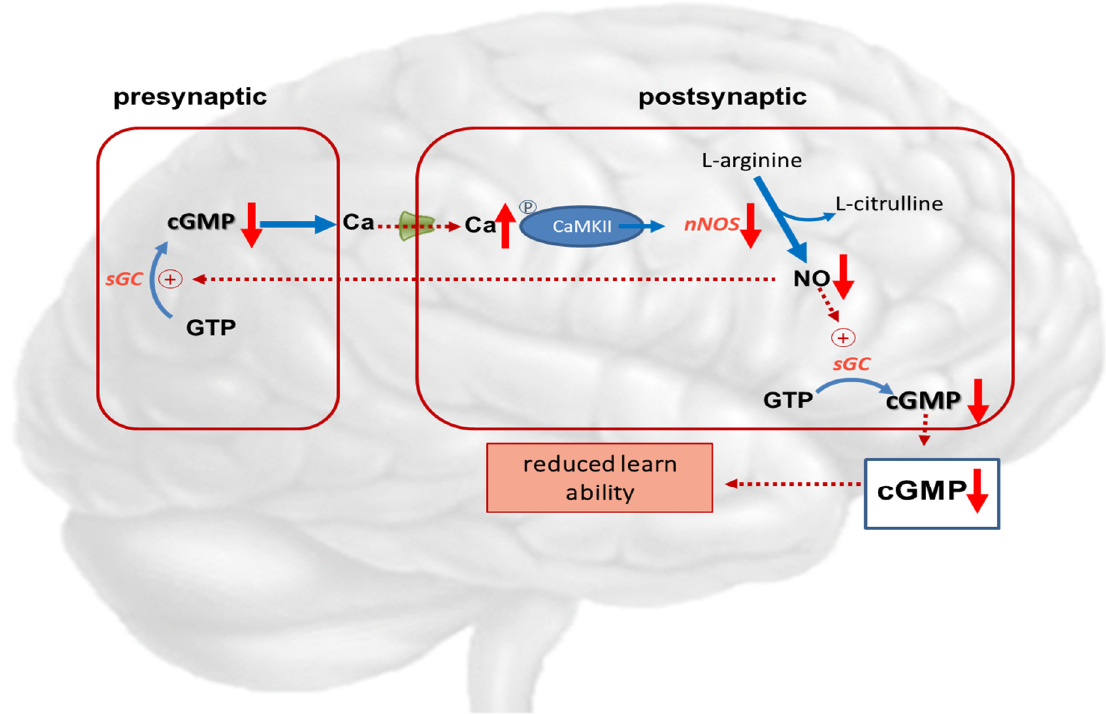
Figure 4. Potential role of cGMP in hepatic encephalopathy. Hyperammonemia reduces the function of the glutamate- nitric oxide-cGMP pathway. Activation of NMDA receptors leads to increased intracellular calcium in the postsynaptic neuron. Calcium binds to calmodulin, which in turn activates function of calcium/calmodulin-dependent protein kinase II (CaMKII) by phosphorylation. CaMKII itself phosphorylates neuronal NO-synthase, reducing its activity and NO formation. This results in reduced synthesis of cGMP, leading to reduced learning